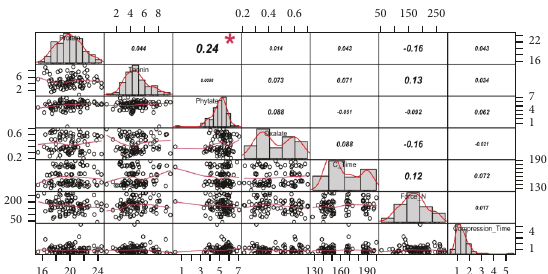
Figure 3: Correlation among physical and chemical traits evaluated in AYB accessions. The association of traits were studied using Pearson’s correlation package in R software version 4.1.1. The x- and y-axis represent the respective scales of each variable under consideration. Belowthe diagramare histograms showingthe distribution of